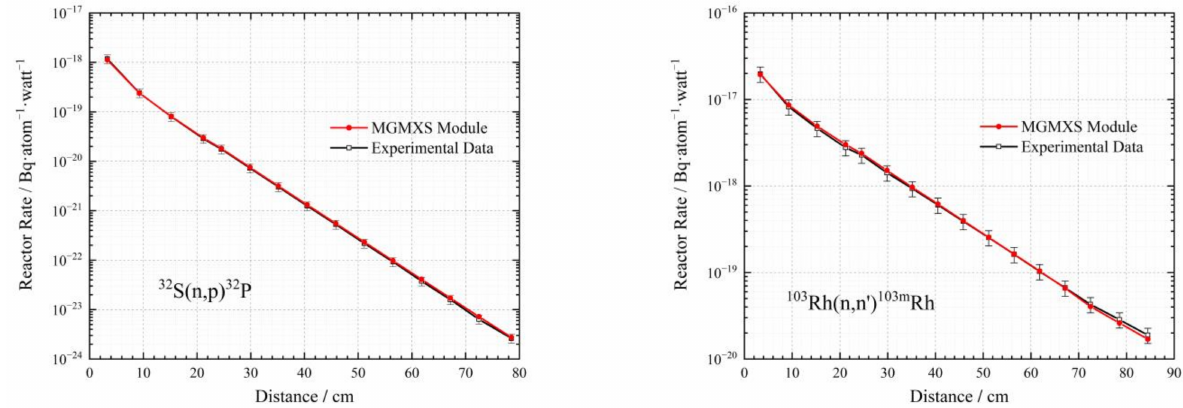
Figure 14. The reaction rate results of detectors for the JANUS Phase I